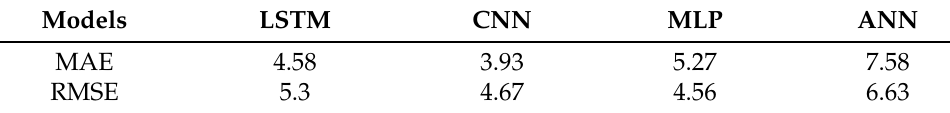
Table 5. Results